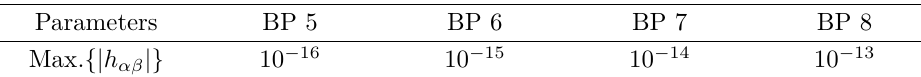
Table 6 . Same as table 2 but with κ = 0 .